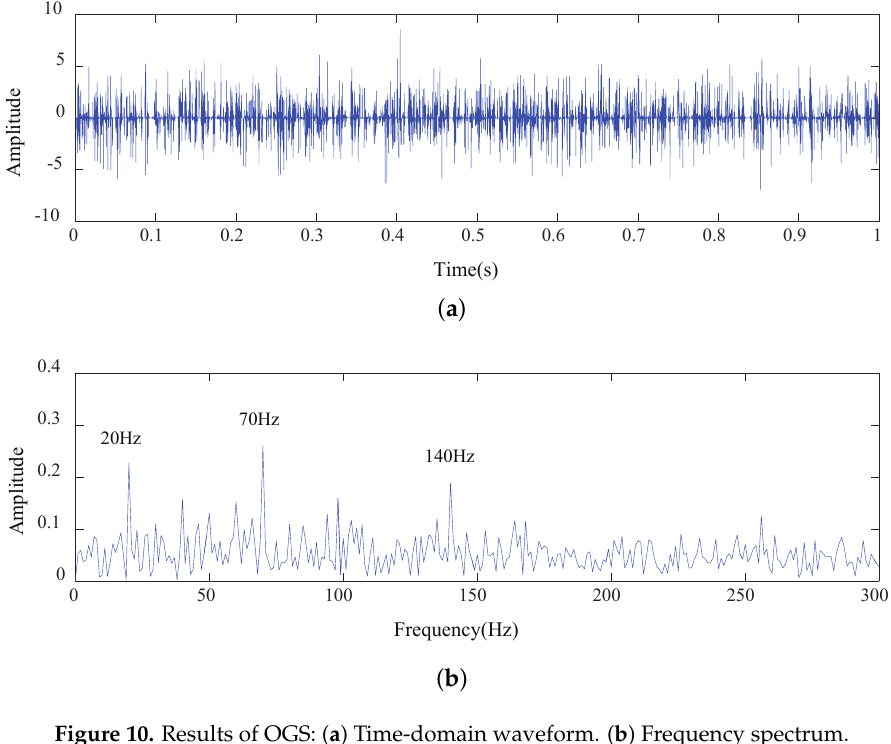
Figure 10. Results of OGS: ( a ) Time-domain waveform. ( b ) Frequency spectrum.